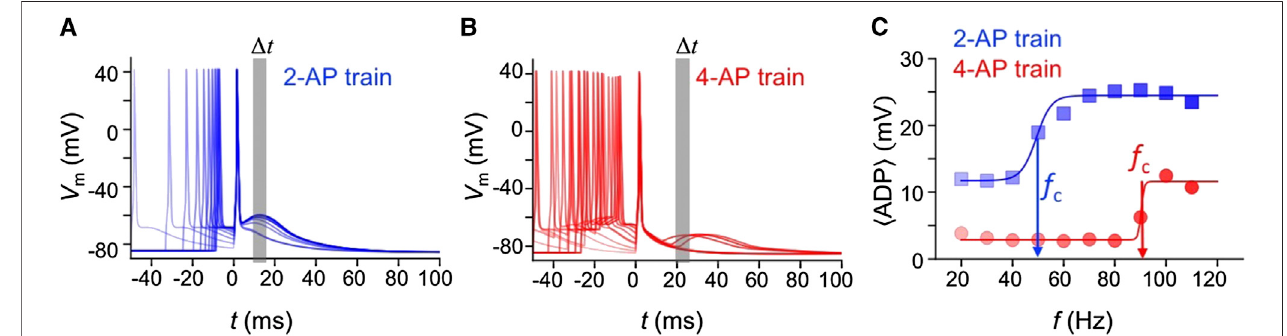
FIGURE2| AfterdepolarizationassociatedwithD-spikes.ThesomaticmembranepotentialalignedtothelastAP,following (A) two-AP,and (B) four-APtrainswith frequencies from 20 ≤ f ≤ 120 Hz. (C) The frequency response of the average ADP, 〈 ADP 〉 , taken over Δ t during two-AP (blue squares) and four-AP trains (red